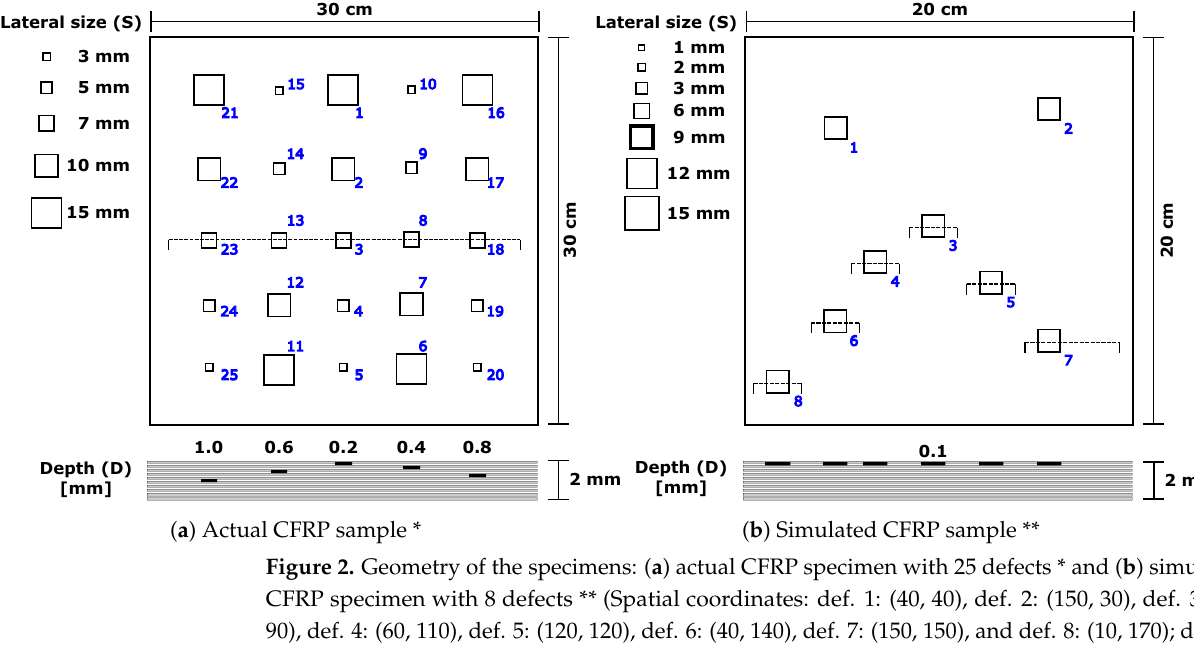
( b ) Simulated CFRP sample ** Figure 2. Geometry of the specimens: ( a ) actual CFRP specimen with 25 defects * and ( b ) simulated CFRP specimen with 8 defects ** (Spatial coordinates: def. 1: (40, 40), def. 2: (150, 30), def. 3: (90, 90), def. 4: (60, 110), def. 5: (120, 120), def. 6: (40, 140), def. 7: (150, 150), and def. 8: (10, 170); depths ( D ) available: 0.1, 0.4, 0.7, 1.0, 1.3, 1.6, and 1.8 mm; thickness ( Th ): 0.1 mm). * Adapted from [31]. Samples and thermal images provided by the Multipolar Infrared Vision (MiViM) research group at Laval University, Quebec (Canada). ** Adapted with permission from [27] © The Optical Society. Table 1. Acquisition conditions for the actual PT experiment. Adapted with permission from [27] © The Optical Society. Image Image Acquisition Excitation Frames Camera